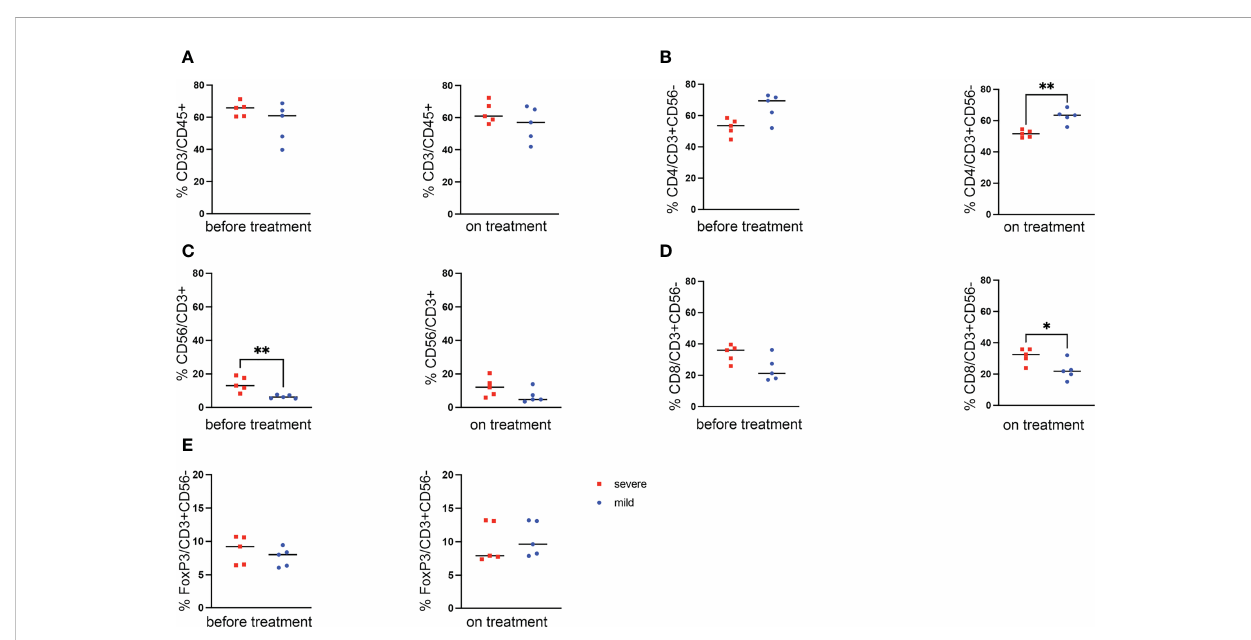
FIGURE 3 Changes of lymphocyte populations in patients treated with PD-1 and CTLA-4 dual ICB. (A) Comparison of mean percentage of CD3 + cells in lymphocytes between two patient groups of cohort 1 (severe vs mild) before treatment and on the treatment (before treatment and 4-6 weeks after start). (B – D) CD4 + (B) , CD56 + (C) and CD8 + T cells (D) at different time points compared between patients developing severe irAEs and patients with only mild side effect. (E) Frequency of FoxP3 + regulatory T cells in the two groups of patients. Statistical analysis was performed by a T test. **